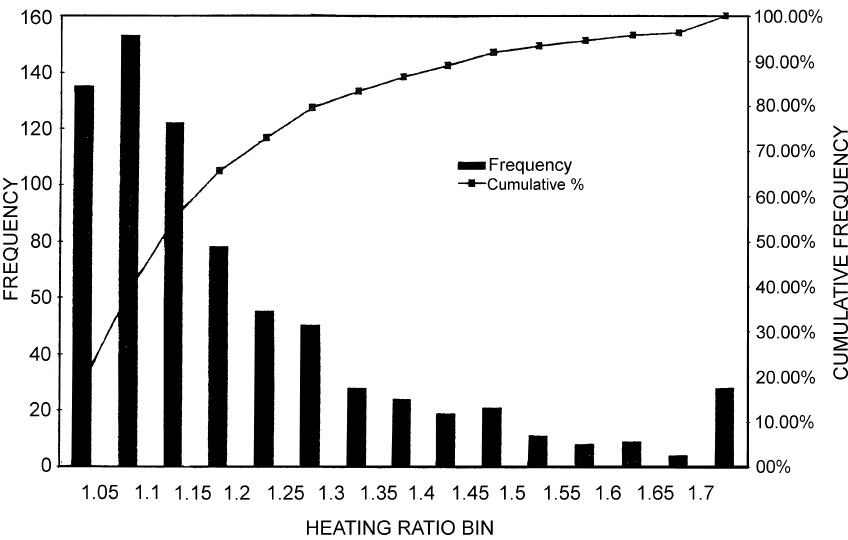
Fig. 2. The frequency distribution of (cid:15) 6 , the ratio of Joule heating determined us- ing 6-minute values to that determined from hourly averages for the entire data